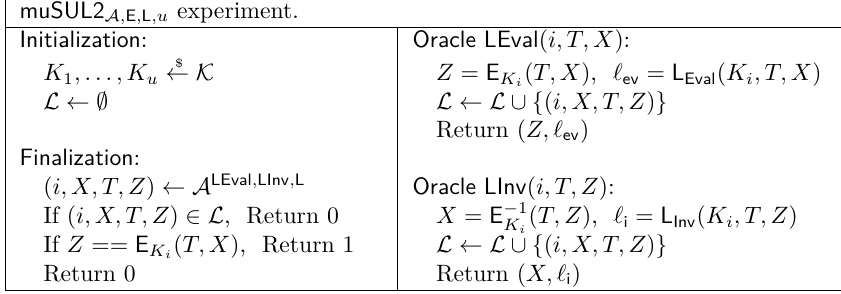
Table 13: Strong unpredictability with leakage in evaluation and inversion experiment. muSUL2 A , E , L ,u